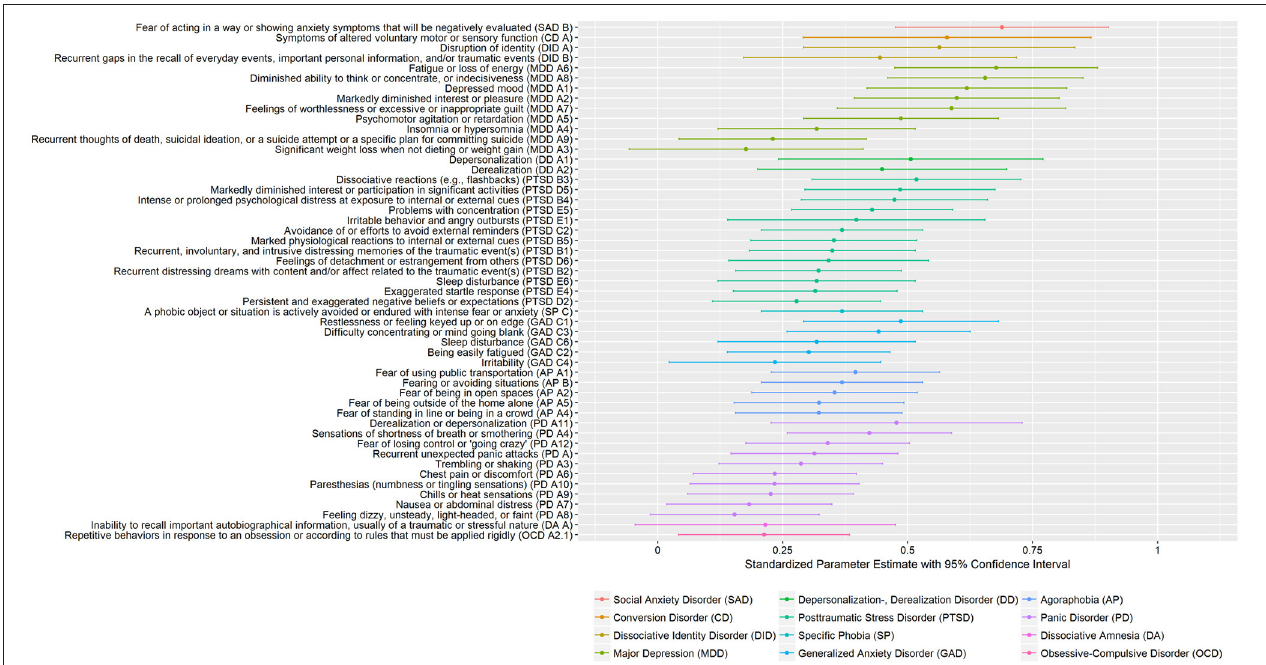
FIGURE 3 | Association between DSM-5 symptoms and functional impairment across WHODAS II domains during 18 months in outpatients and daycare patients ( N = 155). The order of the symptoms in the graph represent descending magnitudes of the mean standardized parameter estimate across the symptoms related to a diagnosis, followed by the standardized parameter estimate magnitude of each symptom related to a diagnosis. The DSM-5 symptom criterion for a symptom is given in